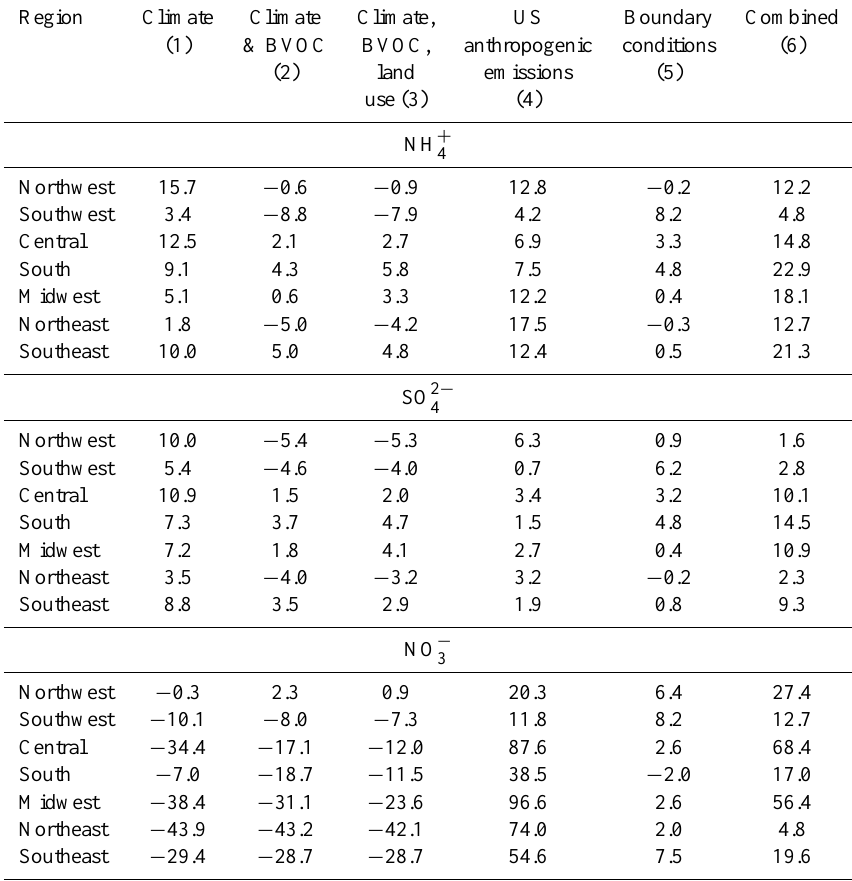
Table 3. Percent change in the aerosol NH + sponding simulation number for each sensitivity simulation is shown in